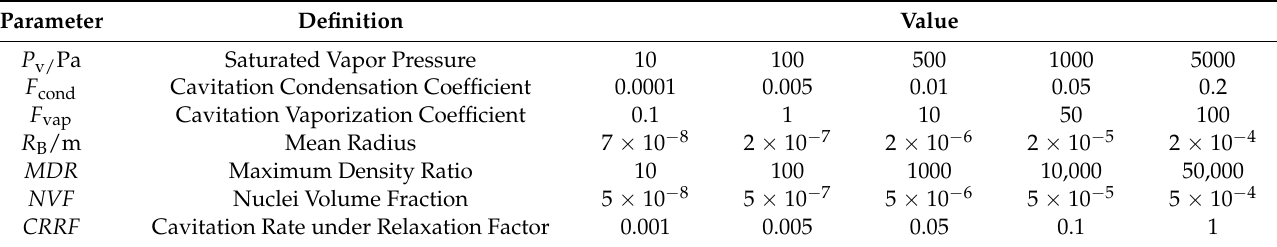
Table 3. Different parameters of cavitation model.